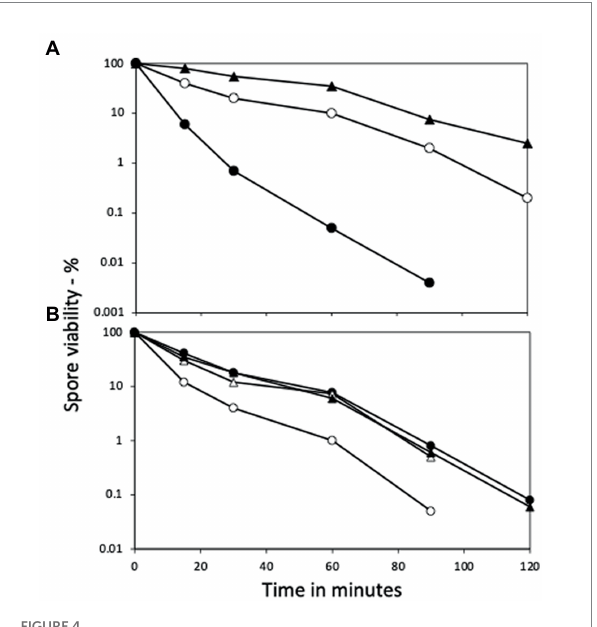
FIGURE 4 Wet heat resistance of spores of wt and yetF strains with yetF at different loci and under control of different promoters. (A) Spores of PS832 (wt), PS4488 ( yetF ) and BH167 (PS4488 with yetF at amyE under control of the yetF promoter) and (B) PS832, BH164 (PS832 with yetF at the yetF locus under control of the sspA promoter), BH165 (PS832 with yetF at amyE under control of the yetF promoter) and BH166 (PS832 with yetF at the yetF locus under control of the yetF promoter) were wet heat treated at either (A) 90 ° C or (B) 95 ° C and spore viabilities were determined as described in Methods. Symbols used are: (A) ○ – PS832, ● – PS4488, and ▲ – BH167; and (B) ○ – PS832, ● – BH164, △ – BH165, and ▲ – BH166. Results are from two experiments where duplicates varied by ≤